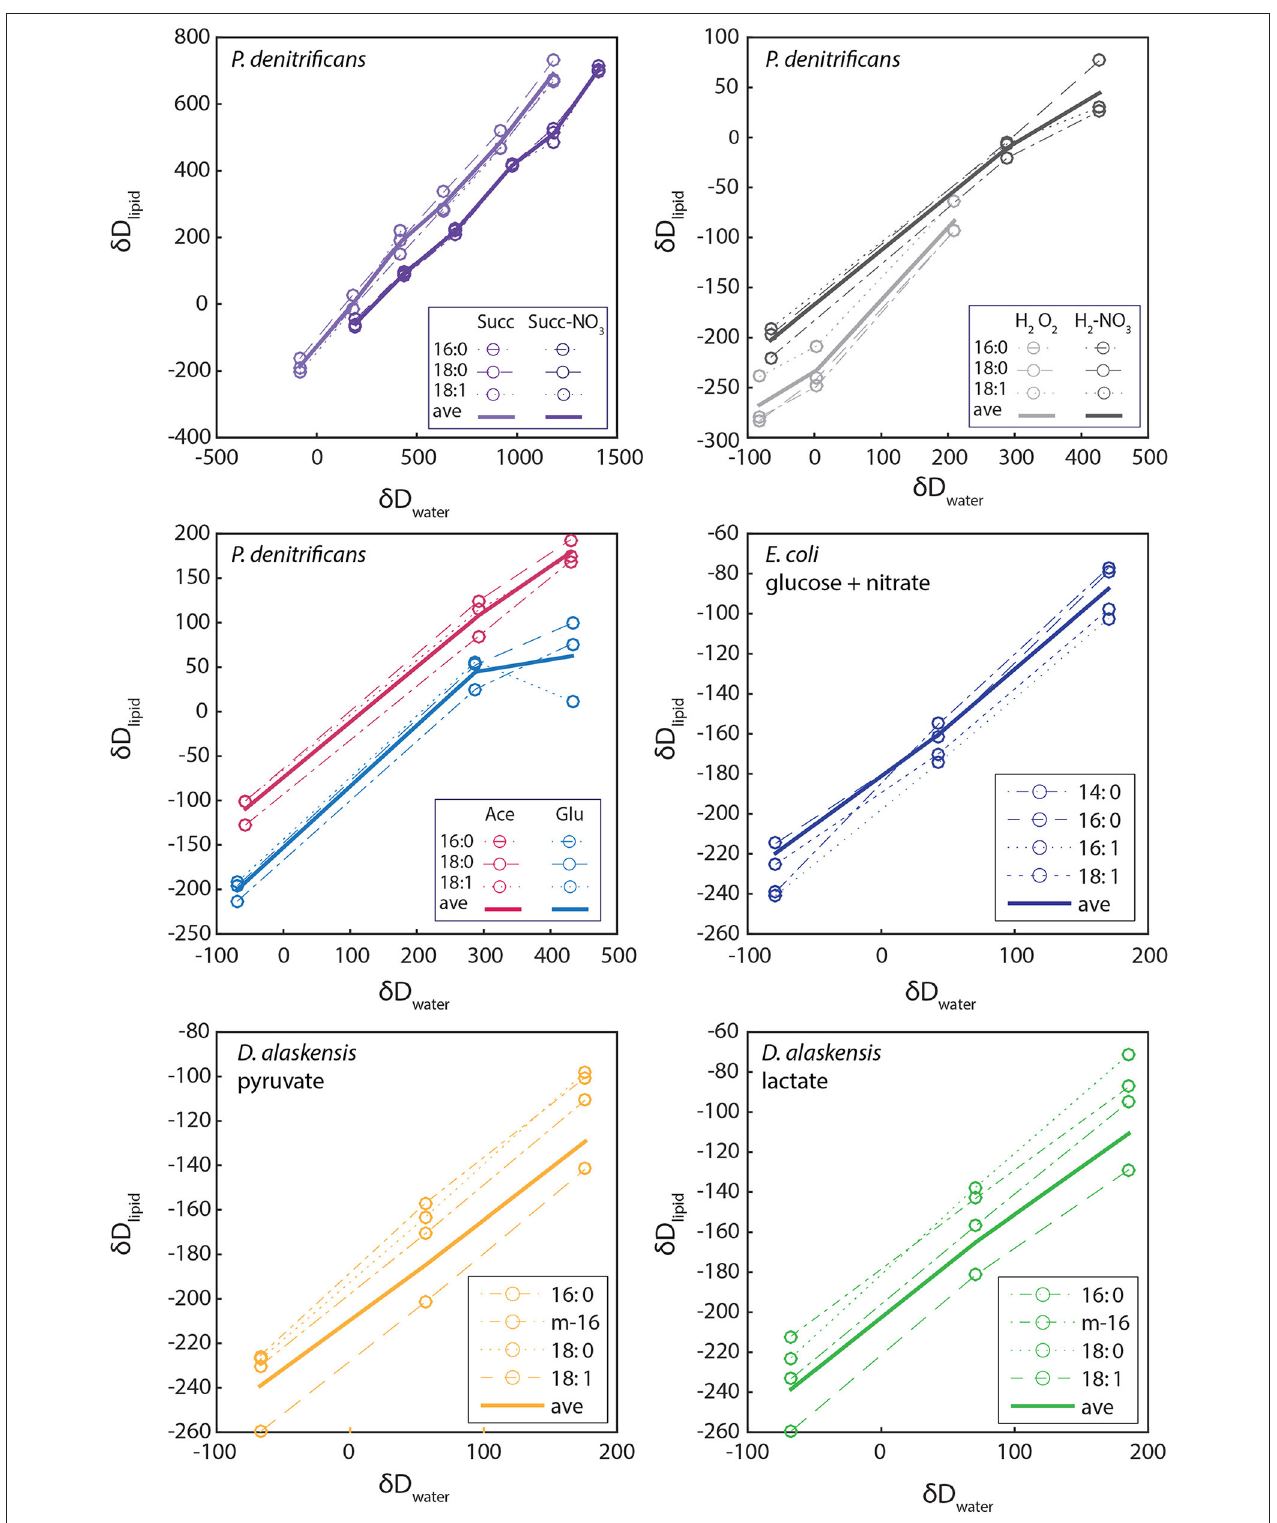
FIGURE 5 | The relationship between hydrogen isotopic composition of growth water and lipids for P. denitrificans, E. coli, and D. alaskensis . Linear regressions (not shown) were performed on the points for weighted average lipid values (bold lines), rather than data for individual lipids (dotted and dashed lines, see